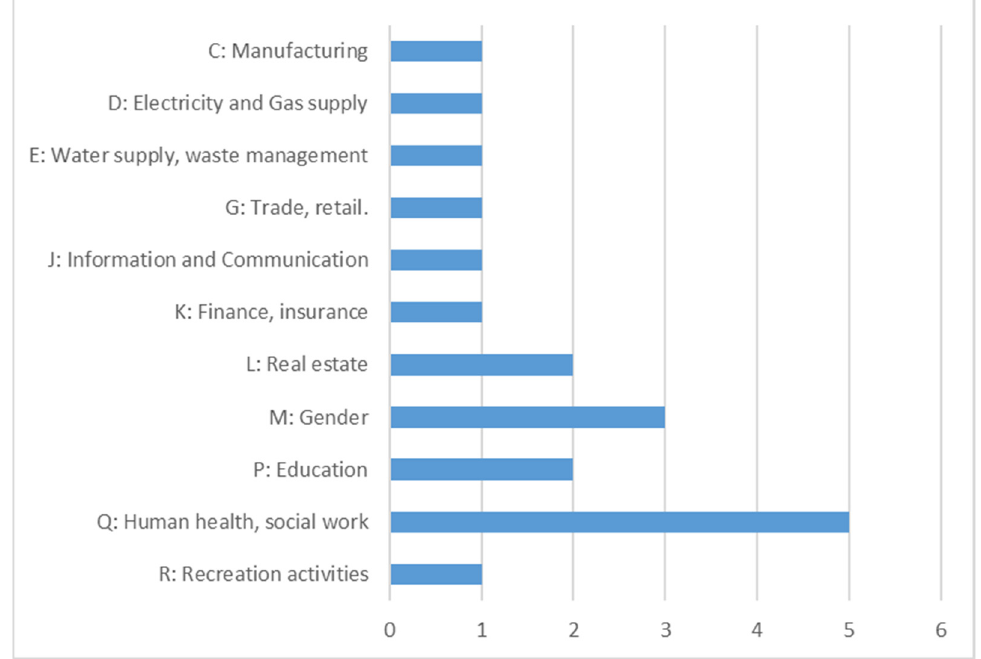
Figure 2. Distribution of the papers of the Special Issue by application